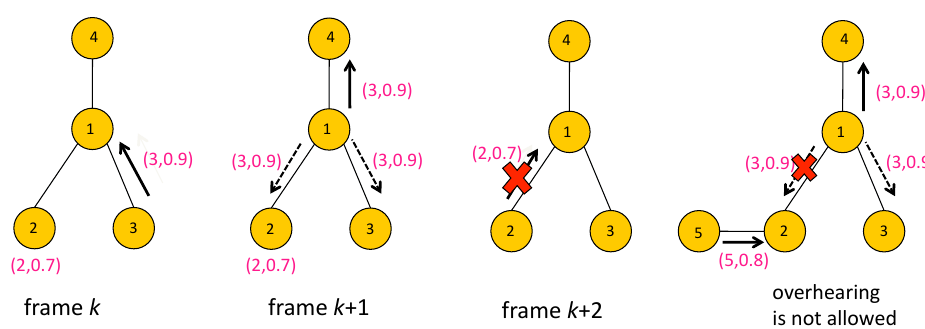
Figure 6. An example of